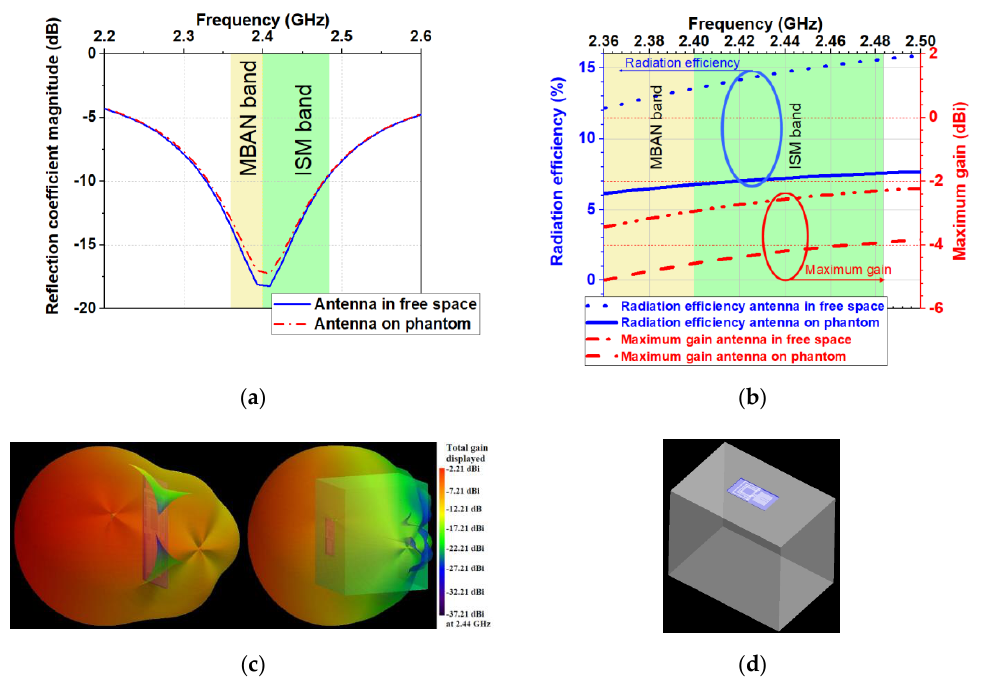
Figure 3. Simulated: ( a ) Reflection coefficient magnitudes versus frequency; ( b ) Radiation efficiency and maximum gain versus frequency; ( c ) 3D radiation patterns of the antenna at 2.44 GHz in the free space and placed on the surface of the phantom; ( d ) Model of the antenna and phantom.